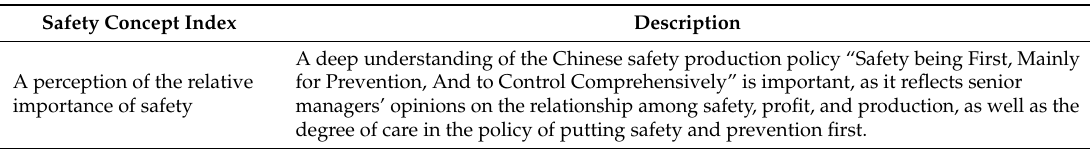
Table 1. Fifteen important safety concept